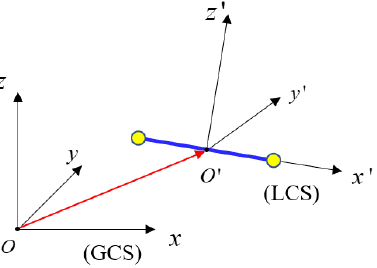
Figure 12. The illustration of strut expressed in LCS and GCS.